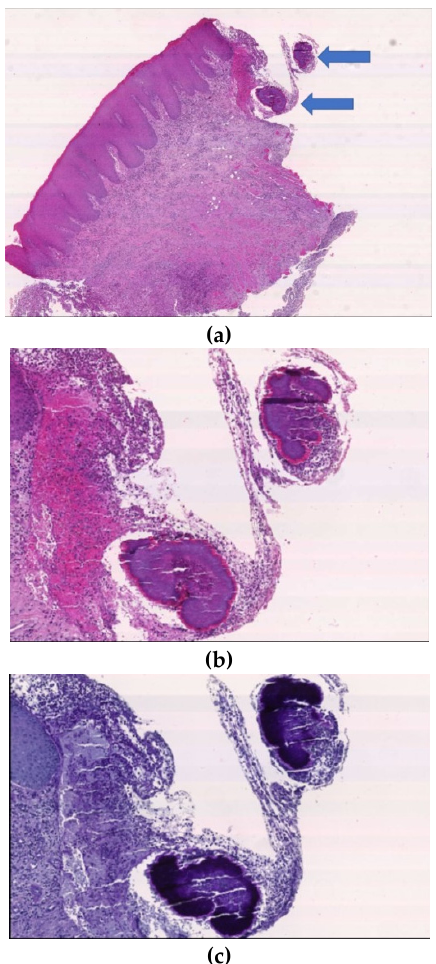
Figure 3. Histopathological examination of the lesion. At small magnification (20 × ; H&E) the oral mucosa shows acute and chronic intense inflammatory infiltration and, at one side of the sample, two aggregates ( a ) better assessed at high magnification (60 × ) ( b ) and after PAS staining ( c ) consistent with Actinomyces spp. colonies. The colonies are composed of Actinomyces spp. filaments, called “sulfurs granules”, surrounded by neutrophilic granulocytes.